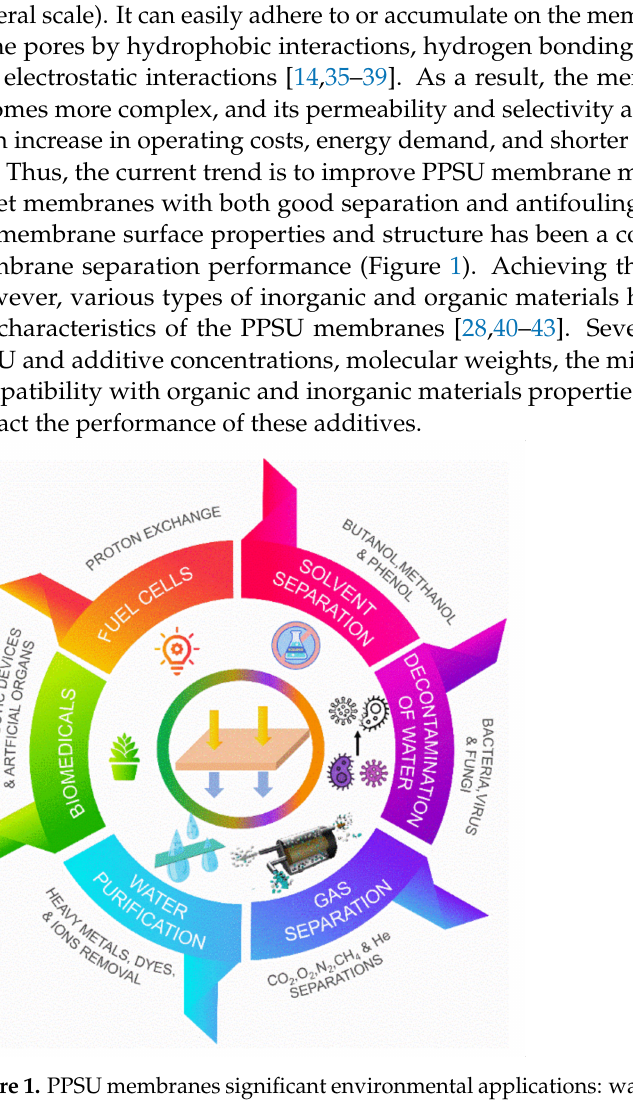
Figure 1. PPSU membranes significant environmental applications: water purification, gas separation, decontamination of water, solvent separation, fuel cell, and